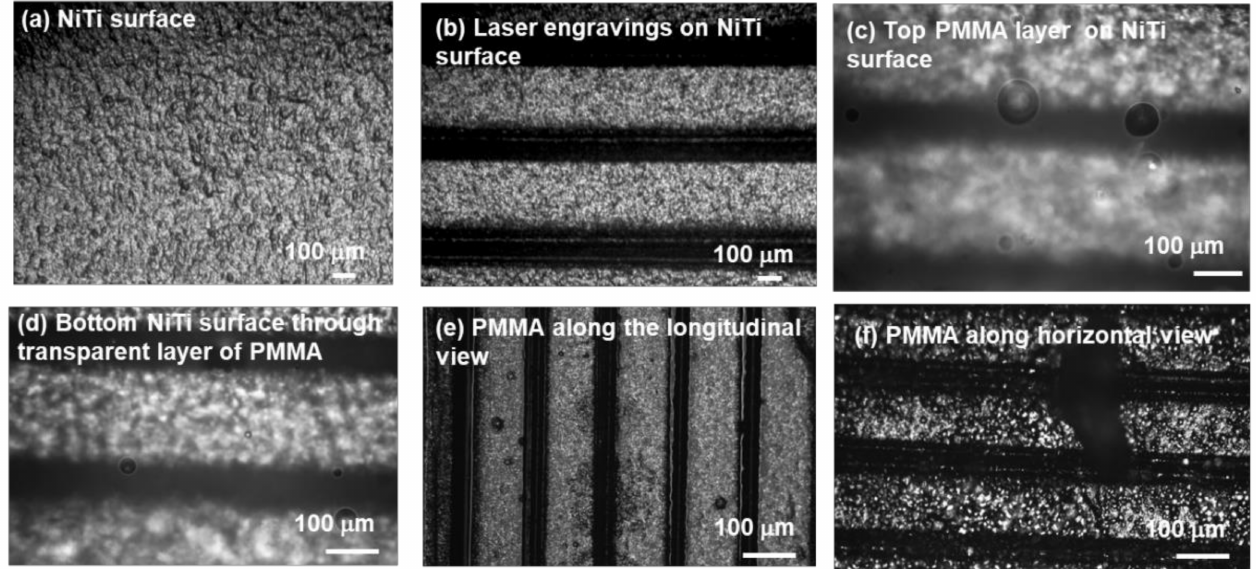
Figure 3. Image of PMMA coating on the NiTi substrate. ( a ) NiTi surface texture; ( b ) NiTi surface with laser line; ( c ) polymer-coated surface (transparent PMMA layer on the surface back surface); ( d ) front surface; ( e ) visual observation in longitudinal lines; ( f ) deposition of PMMA in horizontal